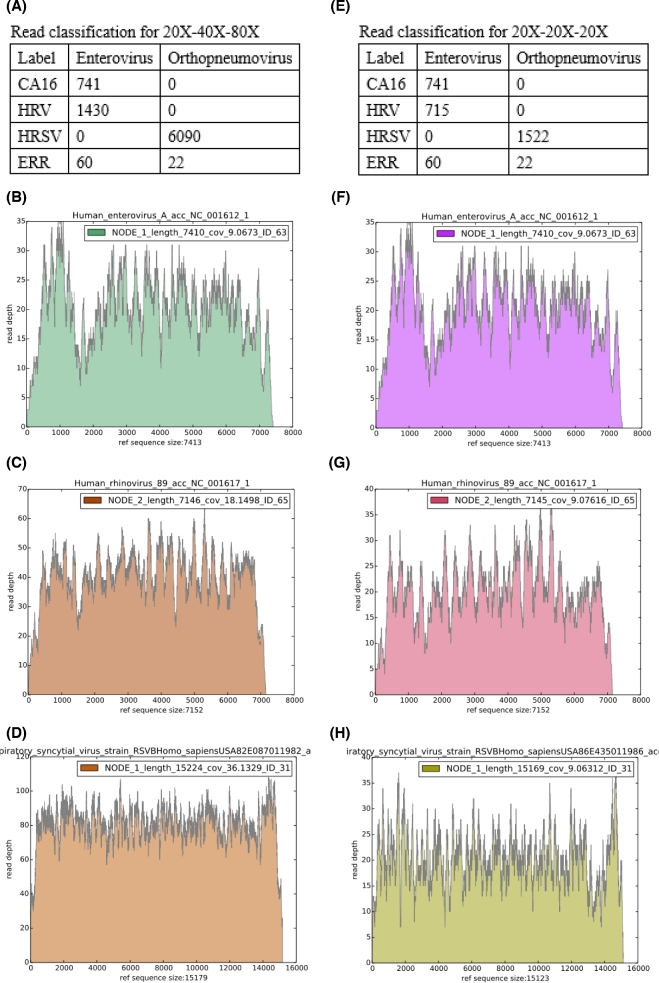
drVM results for read mixture simulations of human enterovirus (CA16), human rhinovirus (HRV), human respiratory syncytial virus (HRSV), and reads from ERR690488. (A-D) 20X-40X-80X: 741 CA16, 1430 HRV, and 6090 HRSV reads. (E-H) 20X-20X-20X: 741 CA16, 715 HRV, and 1522 HRSV reads.